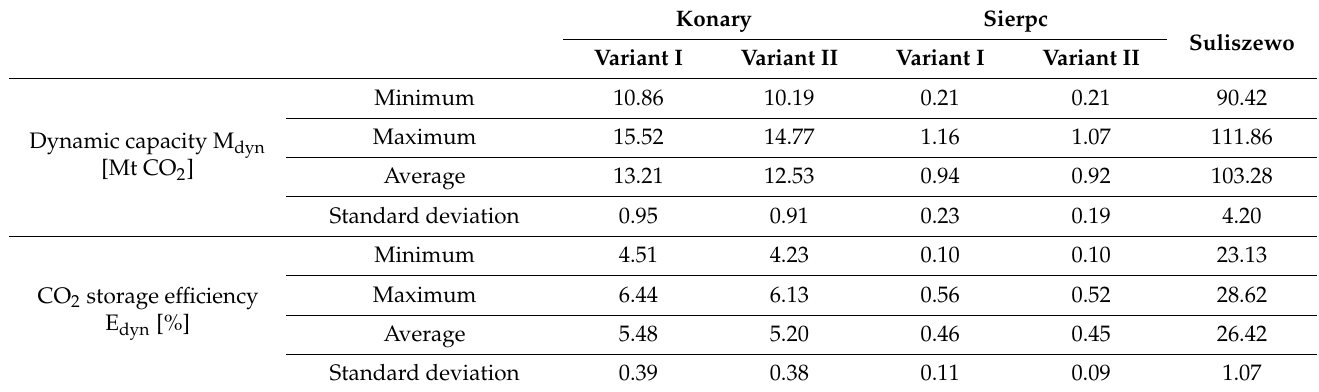
Table 6. Summary of the dynamic storage capacity and storage efficiency of CO 2 in selected structures.